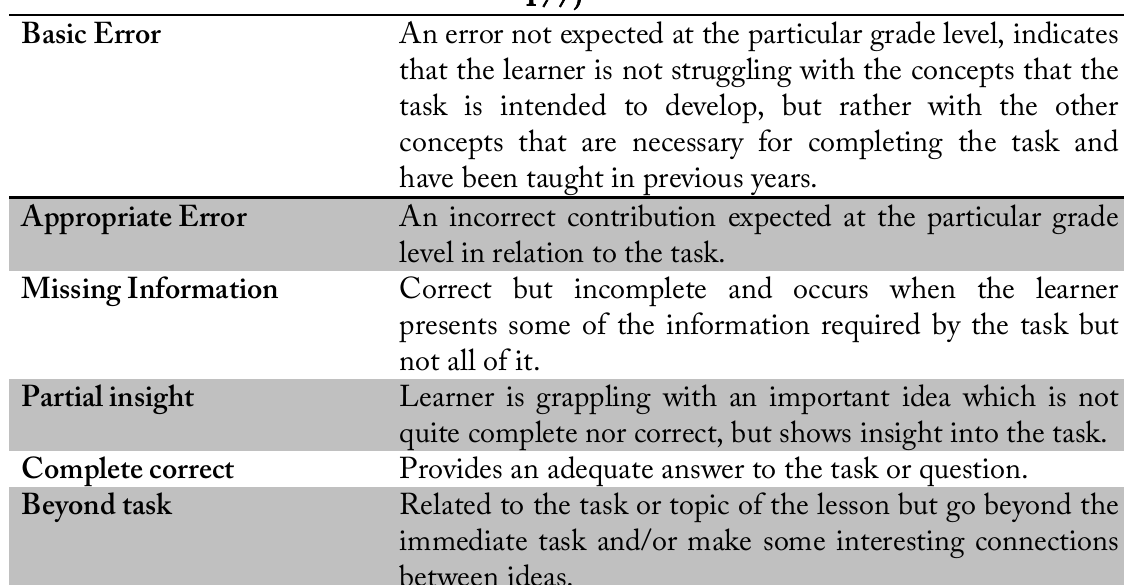
Table 2: Brodie’s coding scheme to categorize learners’ contribution (Brodie, 2005: